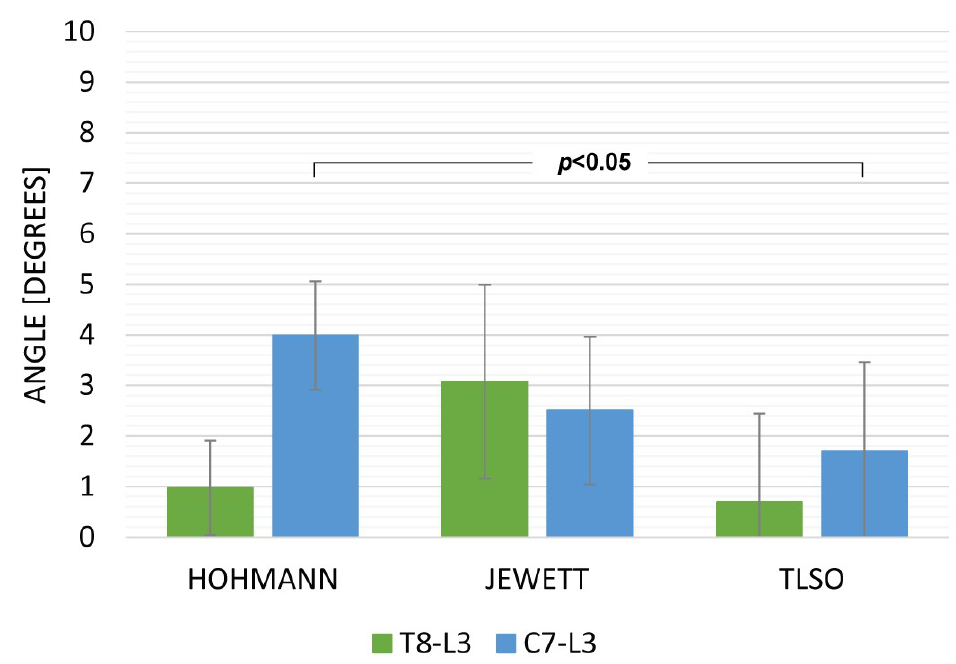
Figure 6. A graphical representation of the maximum axial rotation while lifting an object from the floor.